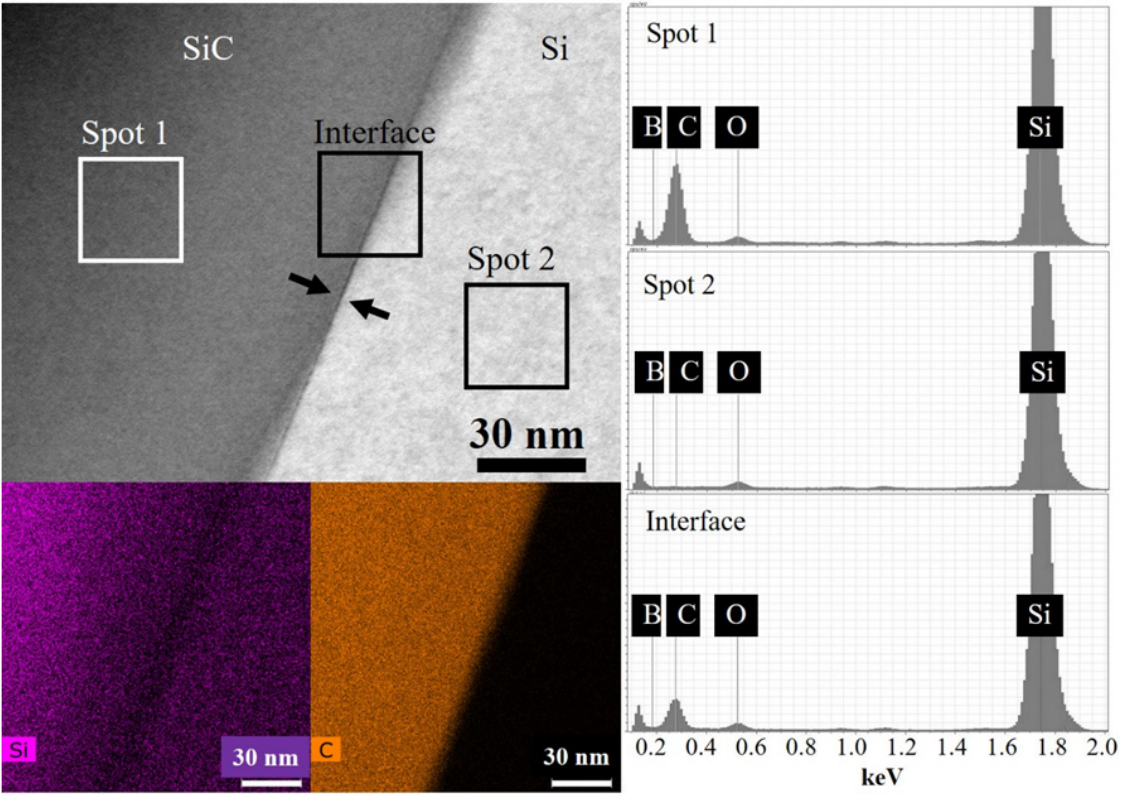
Figure 5. BF-STEM image of SiC particle and Si interface from the SiC-B 4 C-Si composite with corresponding EDS spectra acquired from the indicated locations in the BF-STEM image and EDS elemental maps for Si and C.